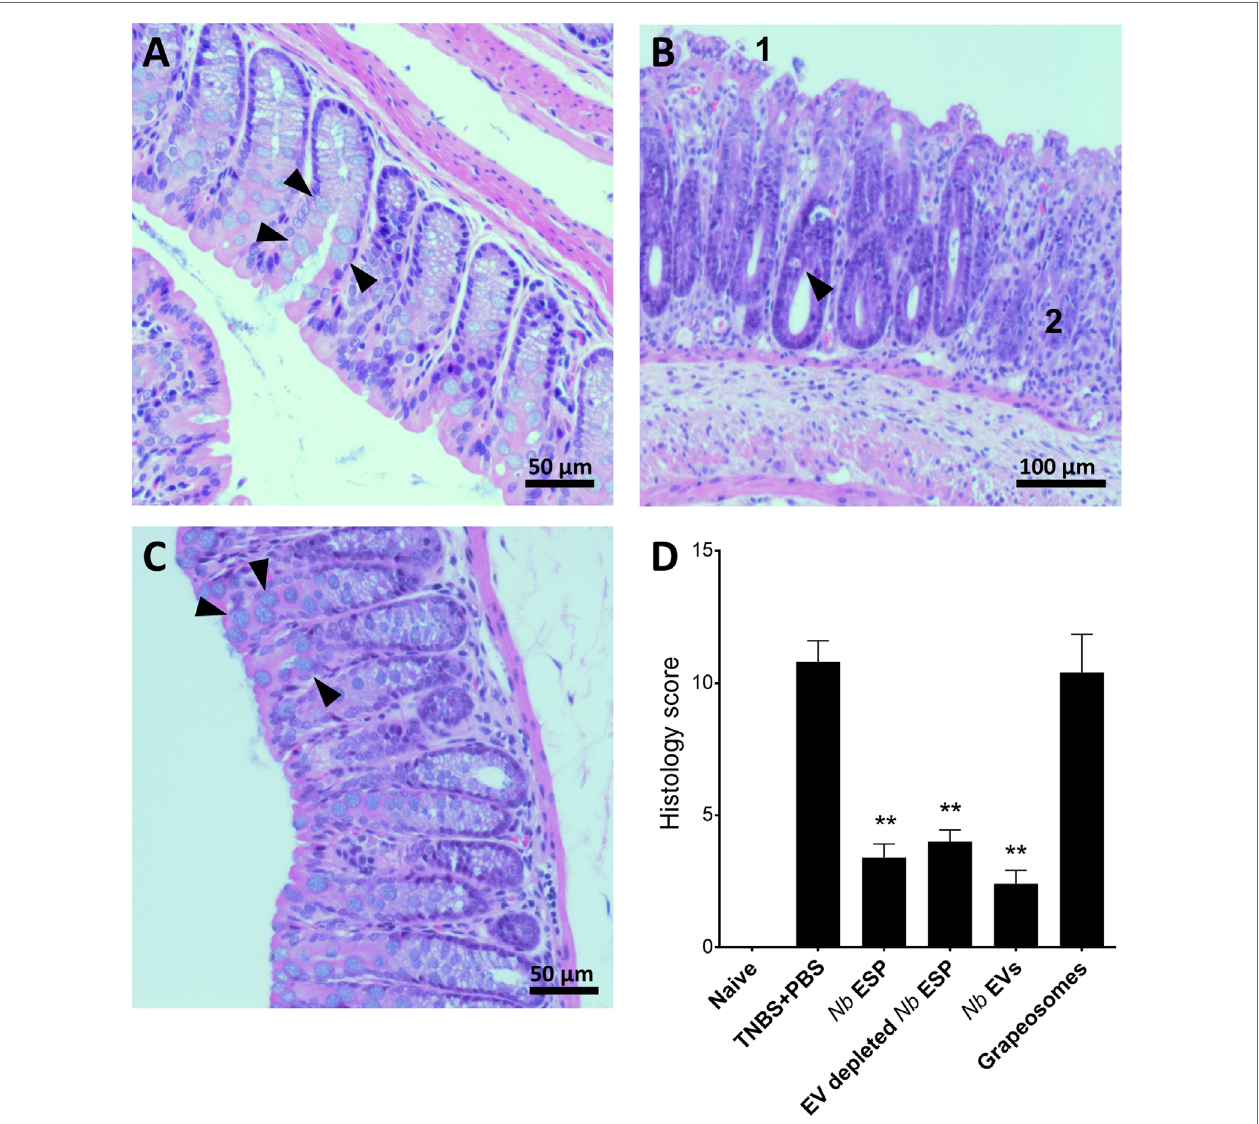
FigUre 4 | Nippostrongylus brasiliensis extracellular vesicles (EVs) protect from TNBS-induced histopathology. Representative photomicrographs of hematoxylin and eosin stained colonic tissue sections. A representative section from the distal colon (~1 cm) was fixed in 4% paraformaldehyde for histological observations. (a) Healthy naïve control mouse; (B) PBS-treated colitis control; (c) N. brasiliensis EV-treated mouse. Arrows point to normal goblet cells (a,c) and goblet cell destruction (B) . (1) Tissue erosion and (2) cellular infiltrates and overall tissue hyperplasia. (D) Histological scoring of histopathology. Statistical analyses were performed by pooling data from groups of mice from two independent but reproducible experiments ( n = 10 mice/group). Error bars represent mean ± SEM. Groups were statistically compared to the PBS + TNBS (colitis) control group (** p <